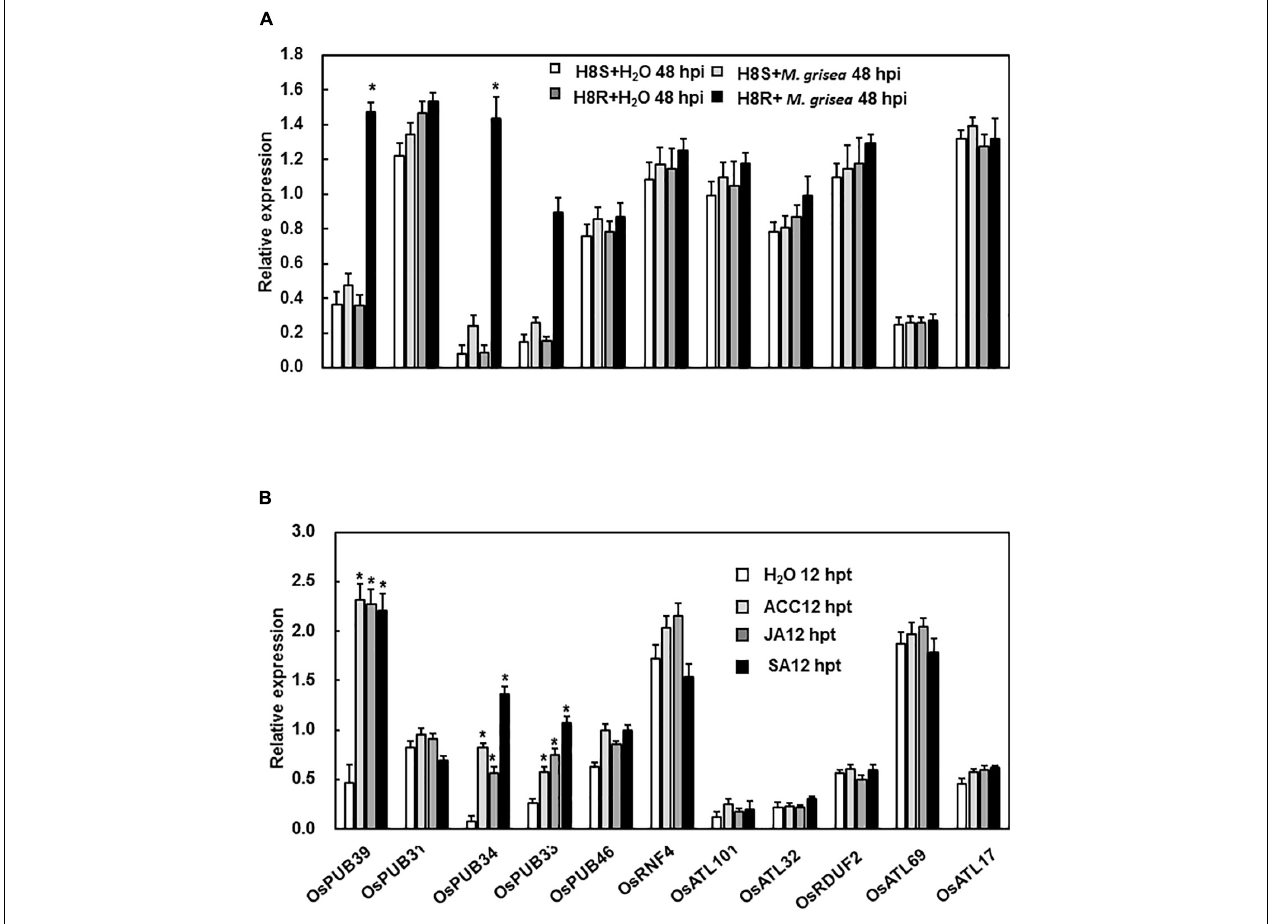
FIGURE 1 | Expression patterns of E3 ubiquitin ligase genes in response to infection by M. grisea and hormone treatment. (A) Expression of E3 ubiquitin ligase genes in response to M. grisea . Leaves of H8R and H8S seedlings were sprayed with a solution of M. grisea spores. (B) Expression of E3 ubiquitin ligase genes in response to signaling hormones. Leaves of 4-week-old Yuanfengzao seedlings were treated with 1.5 mM SA, 100 µ M JA, and 100 µ M ACC solutions by spraying. JA and ACC solutions were prepared in 0.1% ethanol, and SA solution was prepared in water. The same volume of 0.1% ethanol or sterile distilled water was used as control. The samples were harvested at specific time points for the analysis of gene expression. Expression levels were presented as multiples of the OsActin expression level, which was used as standard. Data presented are the means ± SD from three independent experiments, and * above the columns indicate significant differences between the treated plants and control at p < 0.05